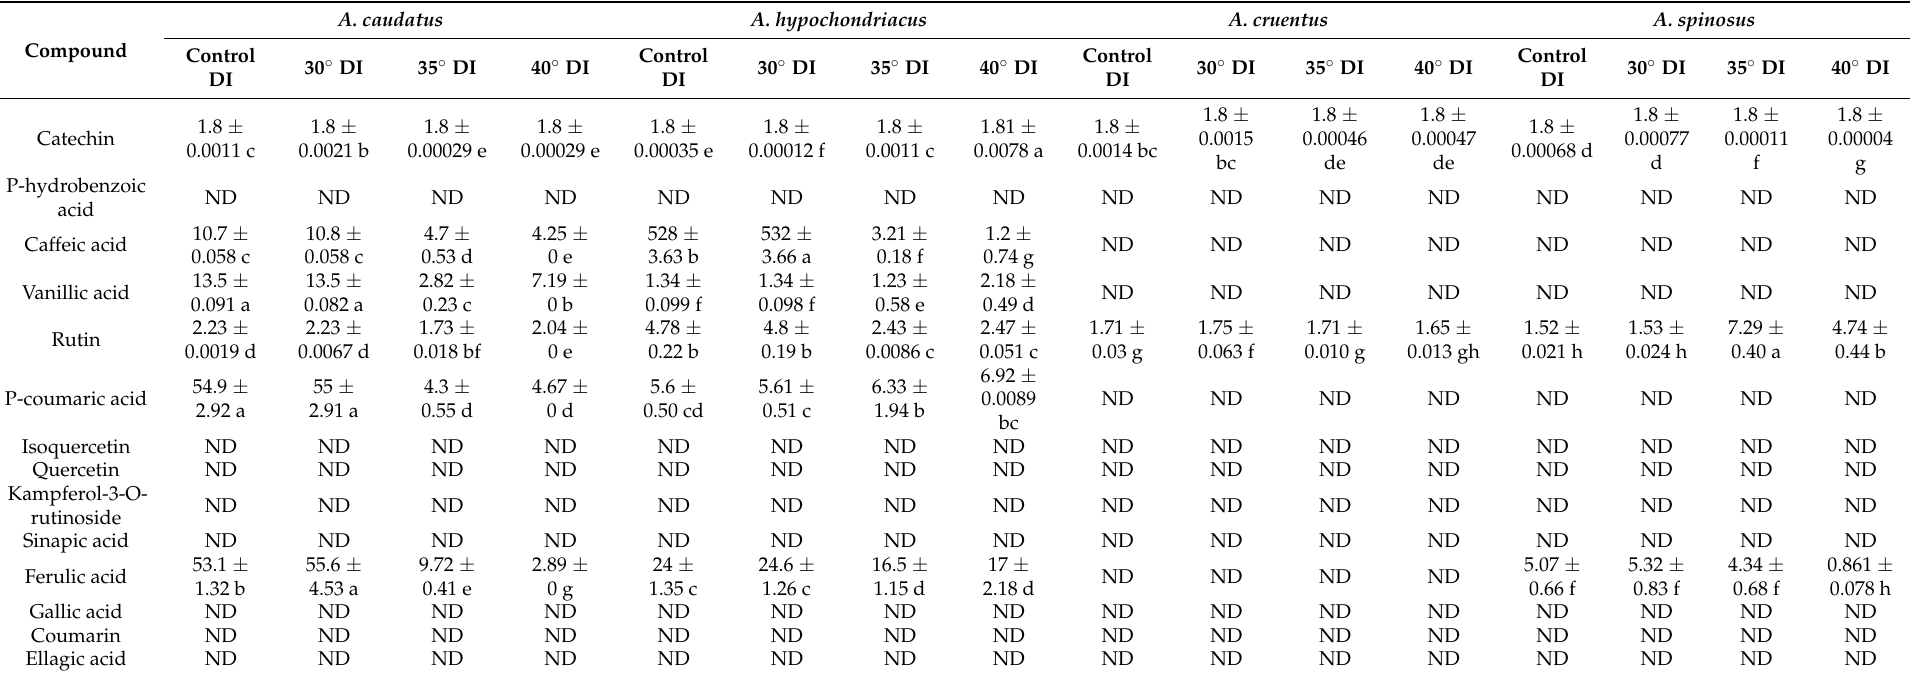
Table 5. Individual phenolic and flavonoids compounds contents detected in aqueous leaves extracts of Amaranthus species treated with different temperature regimes under DI condition ( µ g/g DW). ND (not detected). Data are shown as mean ± standard deviation and different letters in the same row indicate significant differences ( p ≤